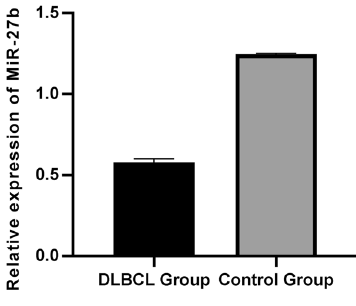
Fig. 1 Down-regulation of miR-27b expression in DLBCL cells. According to the com- parison of miR-27b expression between disease and control groups, miR-27b expression was significantly lower in the disease group compared with the control group (P <